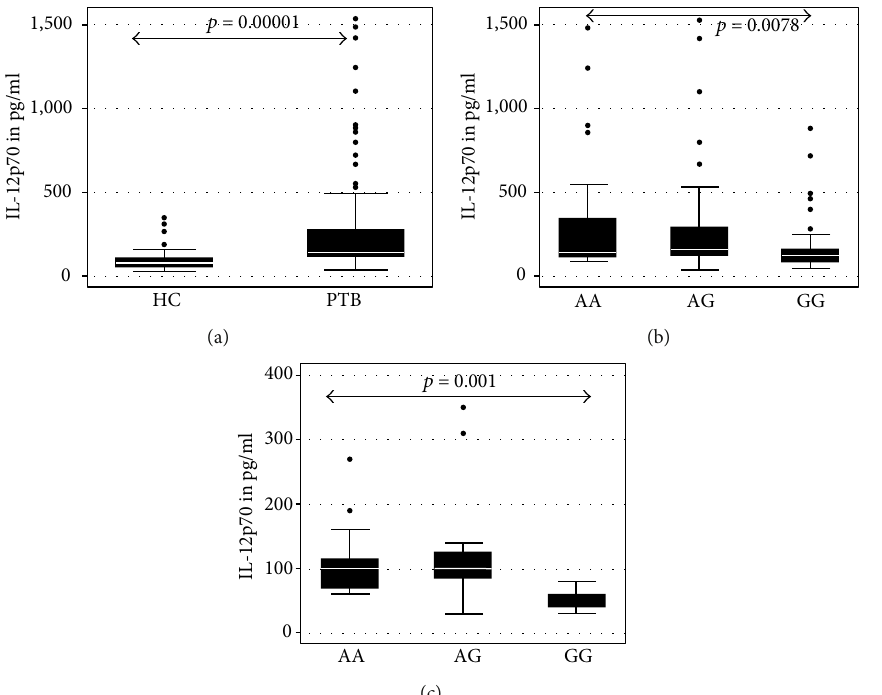
Figure 2: Comparative analysis of serum IL-12p70 level in PTB patients and healthy controls. Serum IL-12p70 was measured by sandwich ELISA using Duoset from R&D Systems, USA, in pulmonary TB patients and controls. The level was expressed as pg/ml on the Y -axis and represented as box and whisker plot. Each dot above the vertical box plot represents the outside value of one subject. Each box is with whiskers on both sides with upper and lower adjacent values, respectively. The box shows the 75 th , median, and 25 th percentile values from the upper hinge to lower hinge, respectively. Subjects are represented on the X -axis. HC: healthy controls; PTB: pulmonary TB patients; AA: subjects with CCL2-2518AA genotypes, AG: subjects with CCL2-2518AG genotype; GG: subjects with CCL2-2518GG genotypes. (a) For comparison of IL-12p70 level between HC and PTB patients. (b) For comparison of IL-12p70 level among PTB patients having various CCL2 genotypes. (c) The comparison of IL-12p70 level among HC having various genotypes. Pairwise comparison was made by the Wilcoxon rank-sum test, and comparison of groups was done by the Kruskal-Wallis equality of populations rank test. p values are shown above the box